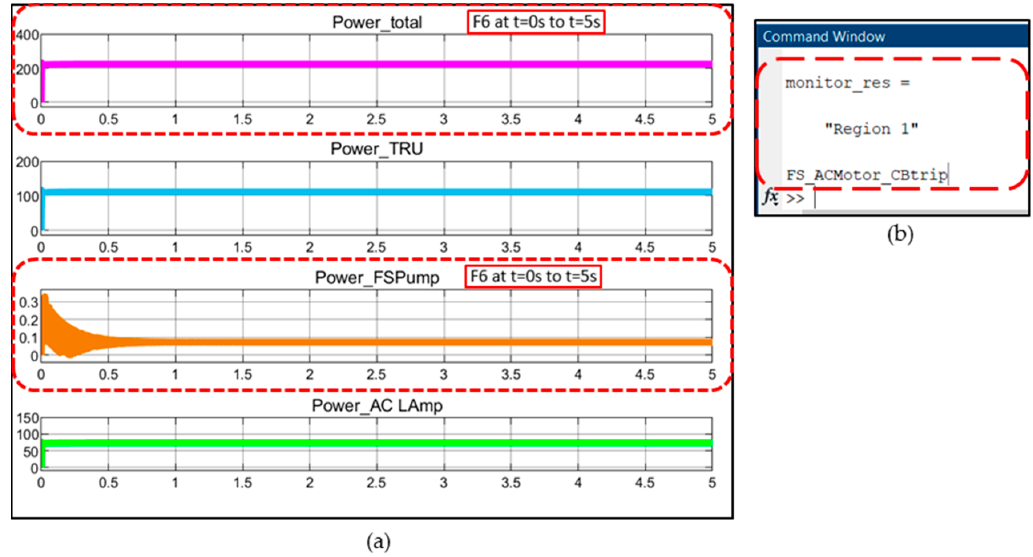
Figure 13. ( a ) Corresponding reaction in apparent power for ACMotor_Fault Injection (F6). ( b ) Method 2 results with the ANFIS monitor and causal reasoning.